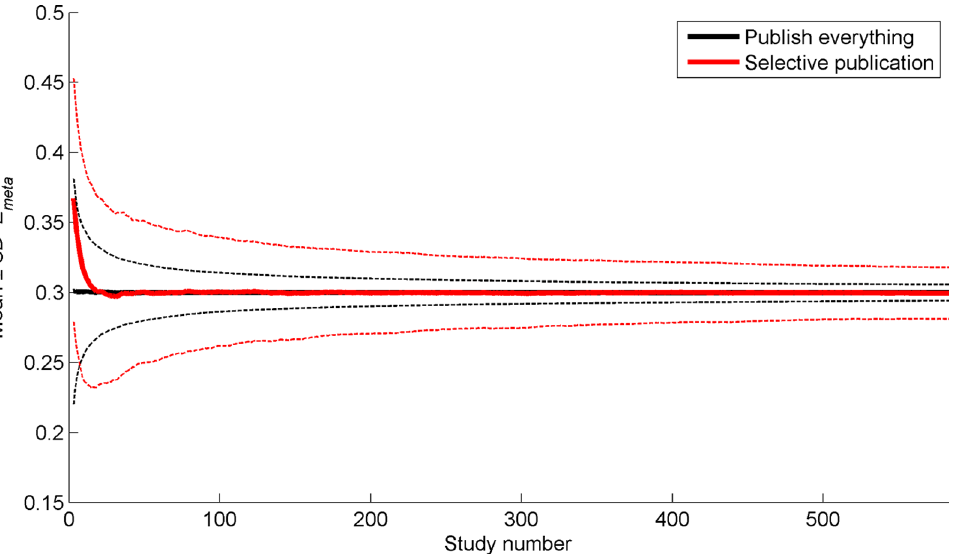
Figure 4. Mean (thicker solid lines) and mean plus/minus one standard deviation (thinner dashed lines) of the cumulative meta- analytic effect as a function of the number of studies. Note that the number of studies can vary per repetition because the simulation was terminated when 40 publications were done under the Selective Publication Approach. Only studies having more than 4,500 out of 5,000 E meta values available are shown (i.e., study numbers 3–585). The means and standard deviations are calculated across the repetitions of the